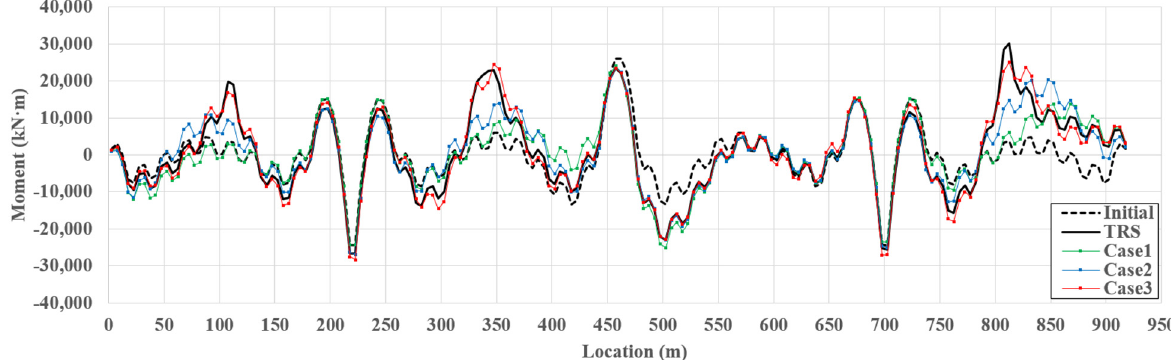
Figure 11. Example of estimated girder moment for TM4.